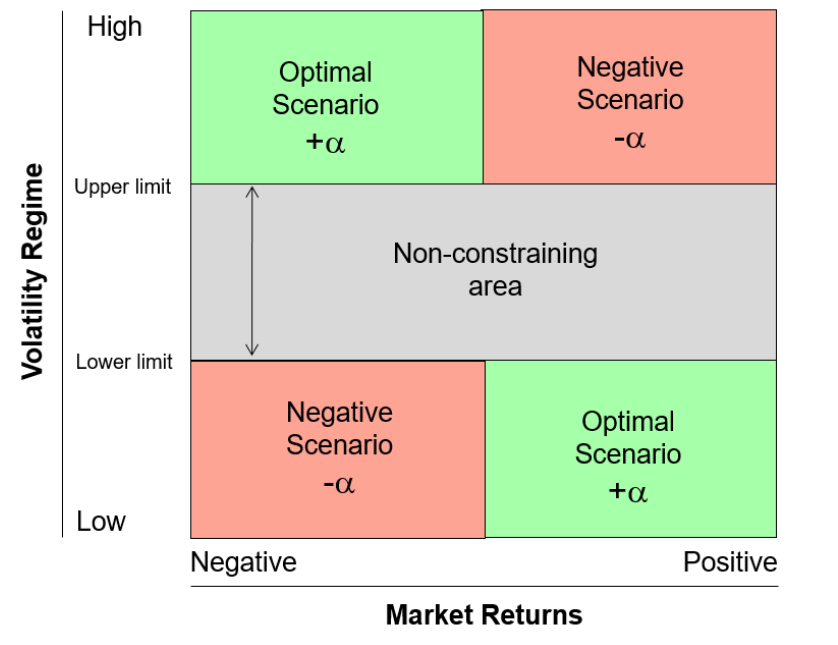
Figure 1. This figure shows the different scenarios of a volatility strategy and its implications for fund